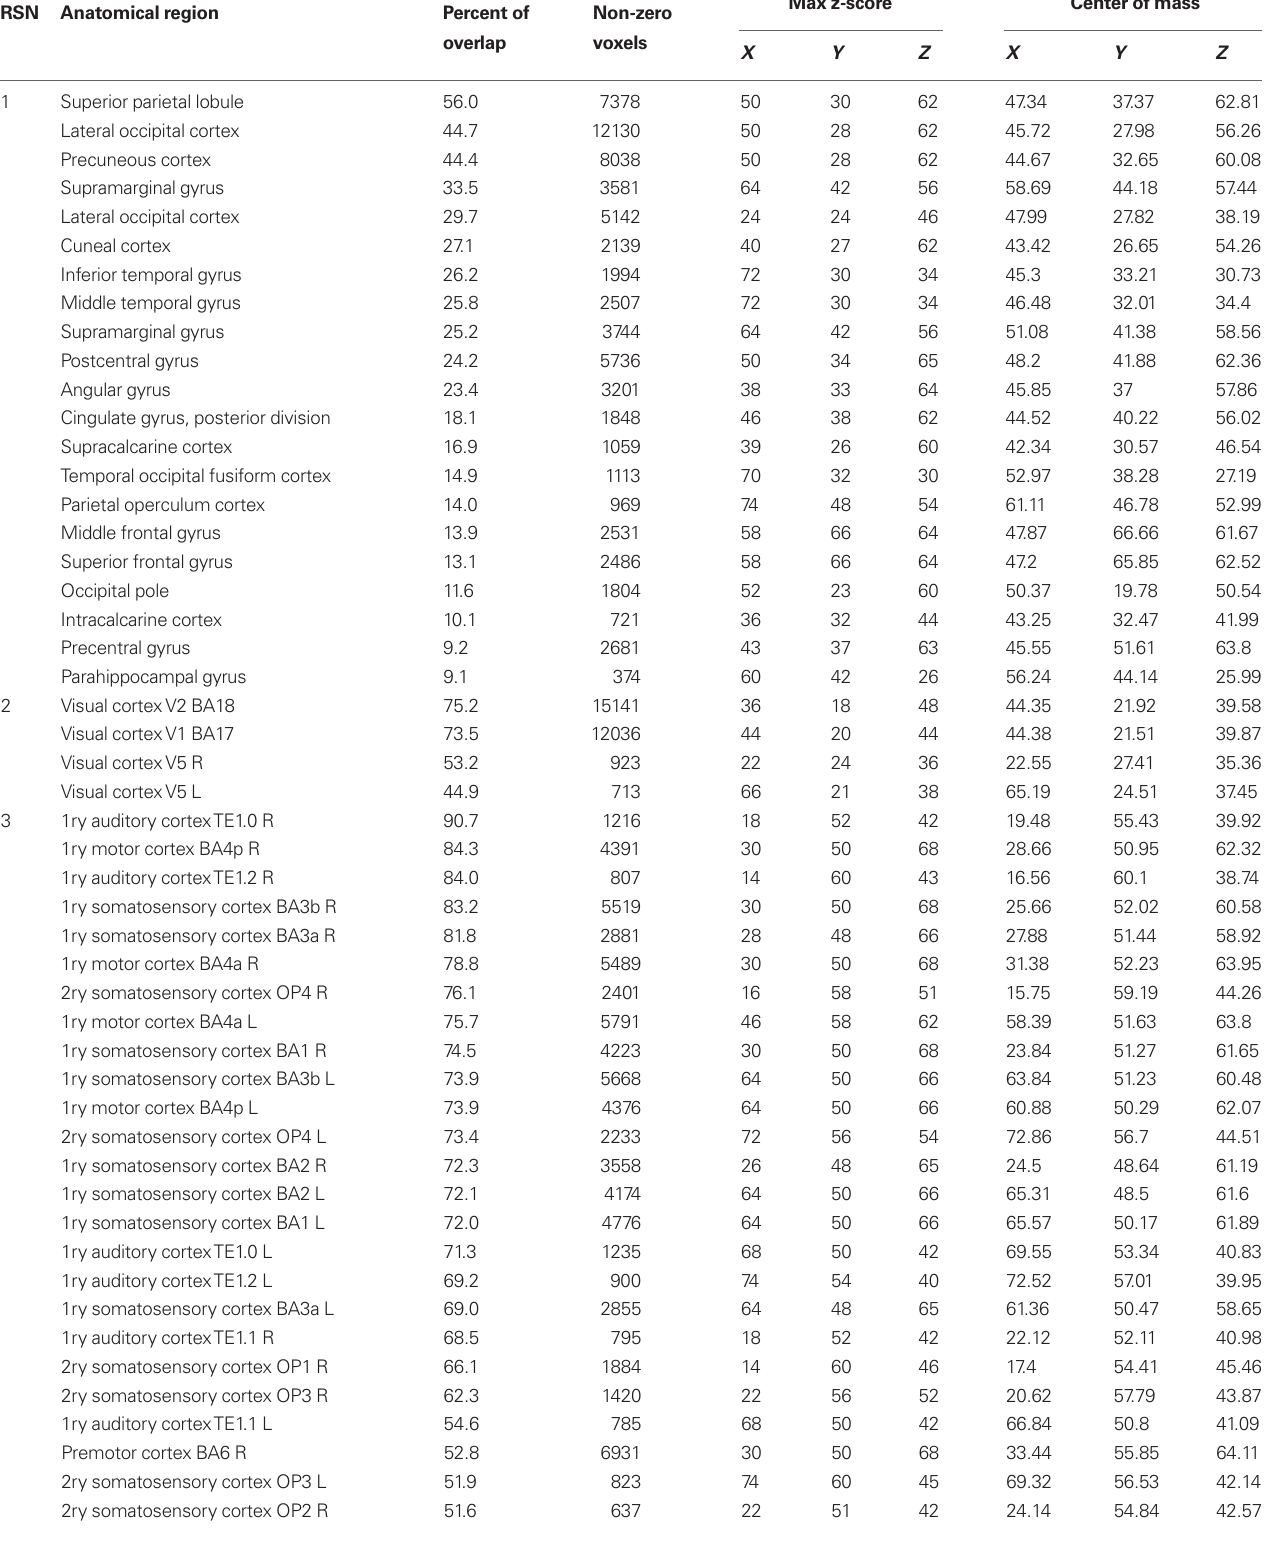
Table 1 | Large-scale resting-state networks (RSNs) which involved significant increased connectivity at model order 20. RSN Anatomical